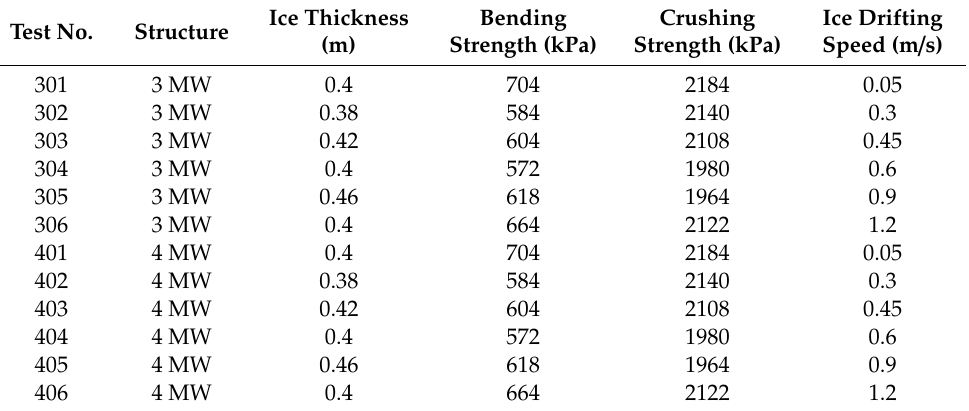
Table 5. Test matrix and measured ice conditions.